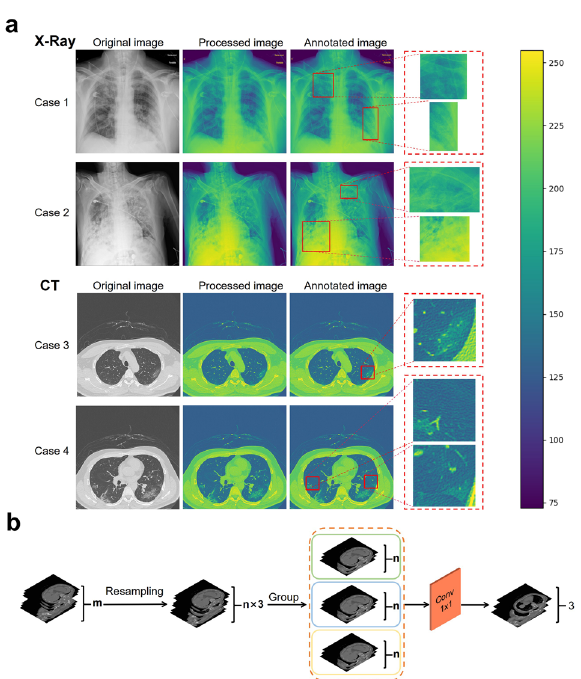
Fig. 1 Demonstrations of data preprocessing methods including pseudo- coloring and dimension normalization. a Pseudo-coloring for abnormal examples in the CXR and CT images. The original grayscale images were transformed into color images using the pseudo-coloring method and were annotated by the experts. The scale bar on the right is the range of pixel values of the image data. b Dimension normalization to reduce the dimensions in the CT images. The number of CT images were fi rst resampled to a multiple of three and then divided into three groups. Followed by the 1 × 1 convolution layers to reduce the dimensions of the